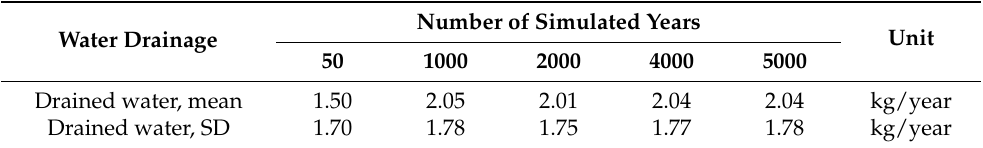
Table 8. Convergence of results, yearly mean and standard deviation of water drained from joint. South facing facade.